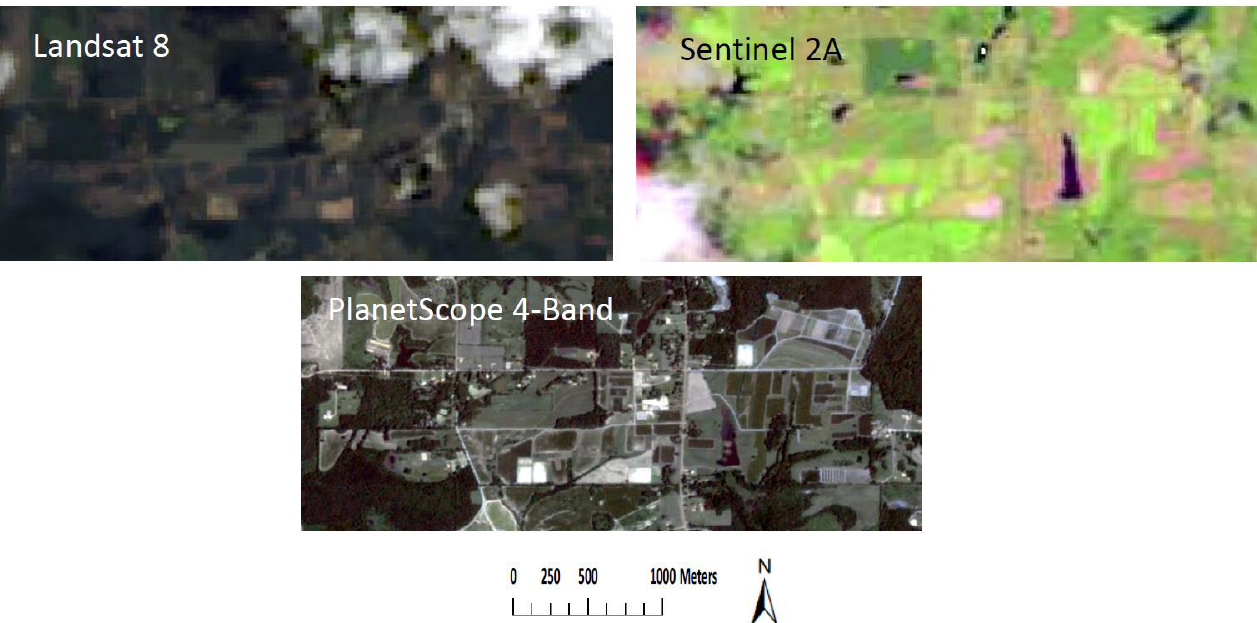
Figure 10. Satellite multispectral imagery of the research farm area at Pontotoc, Mississippi: Landsat 8 (25 July 2018), Sentinel 2A (22 July 2018), and PlanetScope 4-band (4 July 2018).